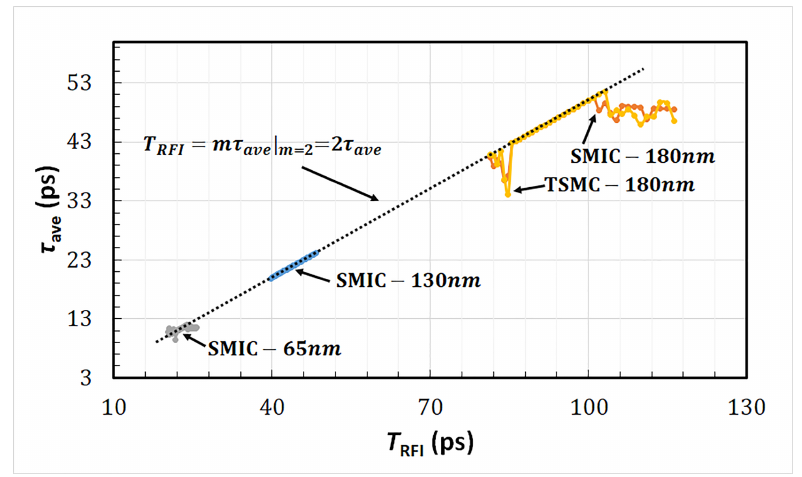
Figure 5. Relationship between interference period and average gate-delay. A RFI is equal to 0.5 V, and m is equal to 2.